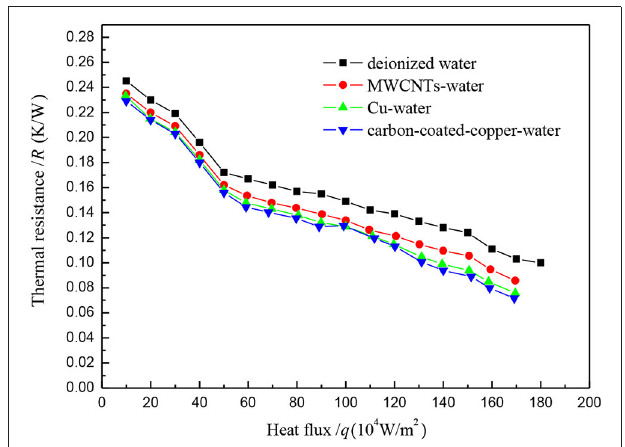
FIGURE 6 | Change of thermal resistance of different mass fraction of the